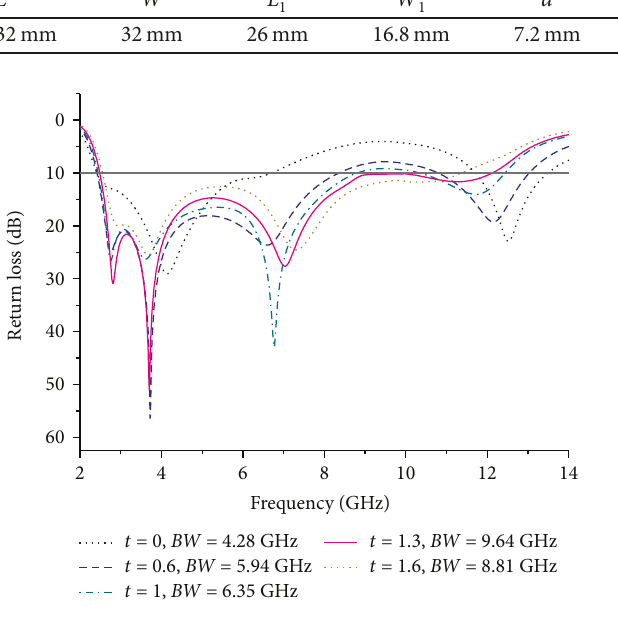
Figure 6: Simulated return loss results for di ff erent t values.